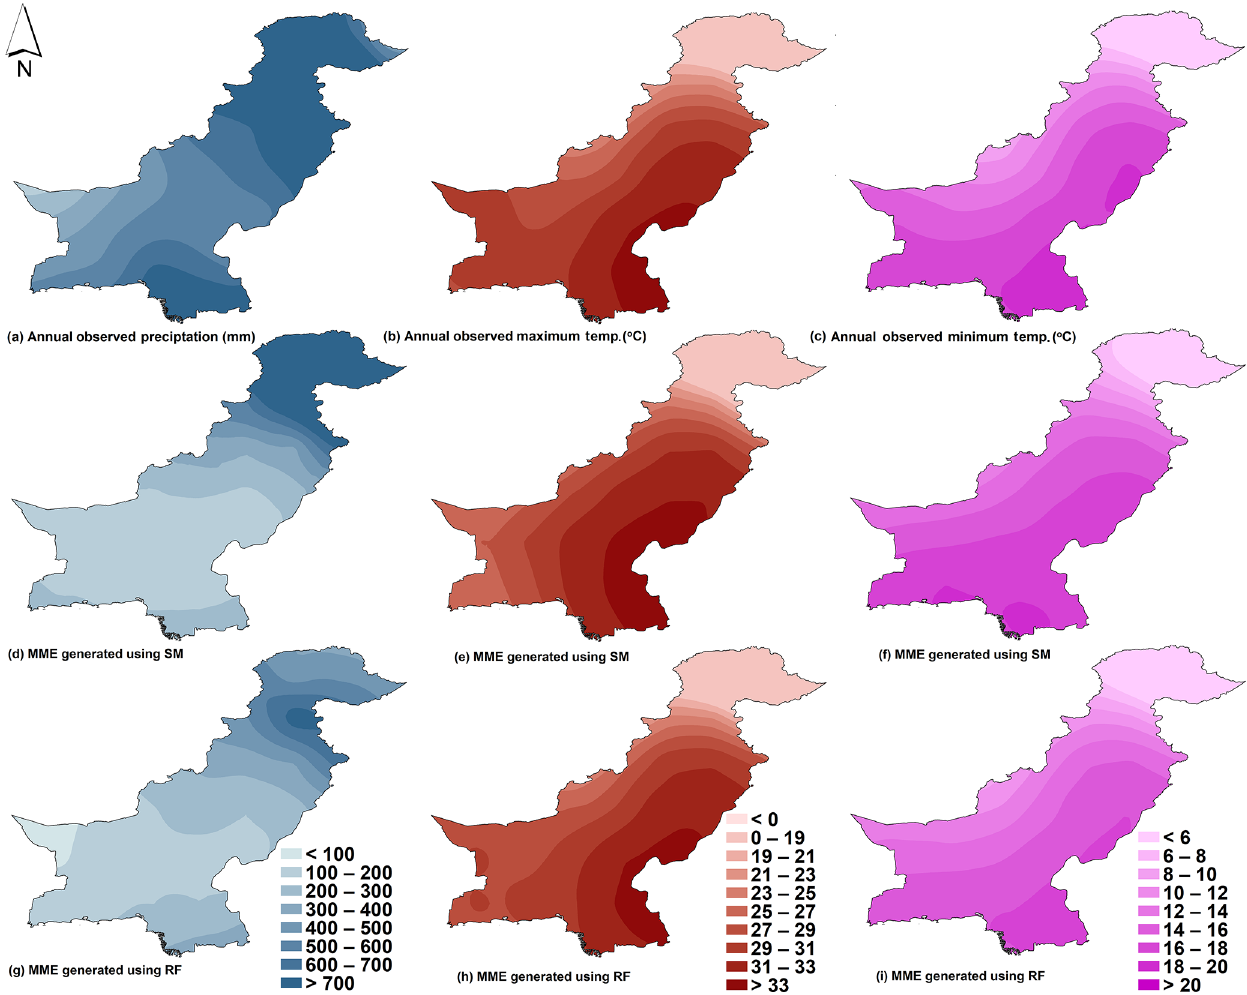
Figure 6. Spatial patterns of (a) GPCC precipitation, (b) CRU maximum temperature, (c) CRU minimum temperature, (d–f) MME-based on simple mean (SM), and (g–i) MME-based on the random forest (RF) algorithm for mean annual precipitation and maximum and minimum temperature for the period 1961 to